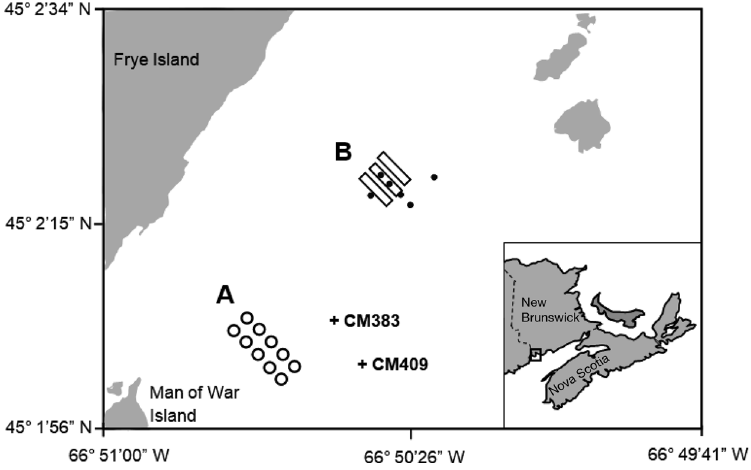
Fig. 1. Locations of 2 Atlantic salmon farms in Bliss Harbour, Passamaquoddy Bay, Bay of Fundy (rectangle in the inset map). Previous studies at Farm A (cir- cles) are described in Chang et al. (2014a) and Wu et al. (2014) and at Farm B (rectangles) in Hargrave et al. (1993) and Hargrave (1994). (+) indicates posi- tions of acoustic Doppler current profiler moorings at sites CM383 (8 June− 7 August 2009) and CM409 (21 September−17 November 2009) described in Chang et al. (2014a). Filled circles: locations of sediment trap moorings at Farm B under, adjacent to and +25 and +50 m from the net-pen array